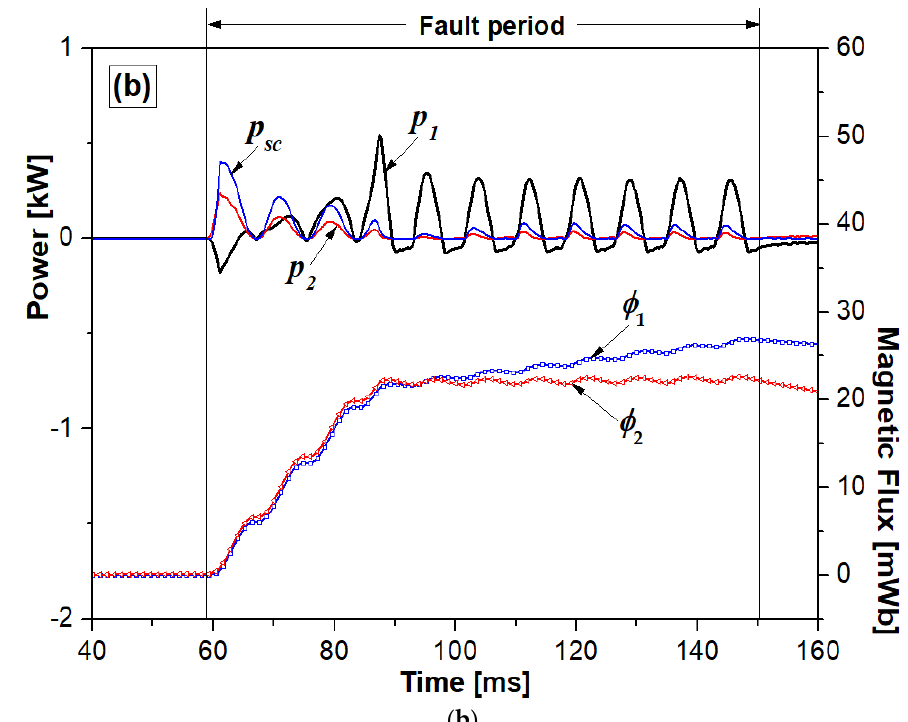
Figure 5. Instantaneous powers and magnetic flux in each winding of bridge type SFCL with a single HTSC element using flux-coupling according to the connection direction between N 1 and N 2 . ( a ) In the case of the subtractive polarity winding. ( b ) In the case of the additive polarity winding.